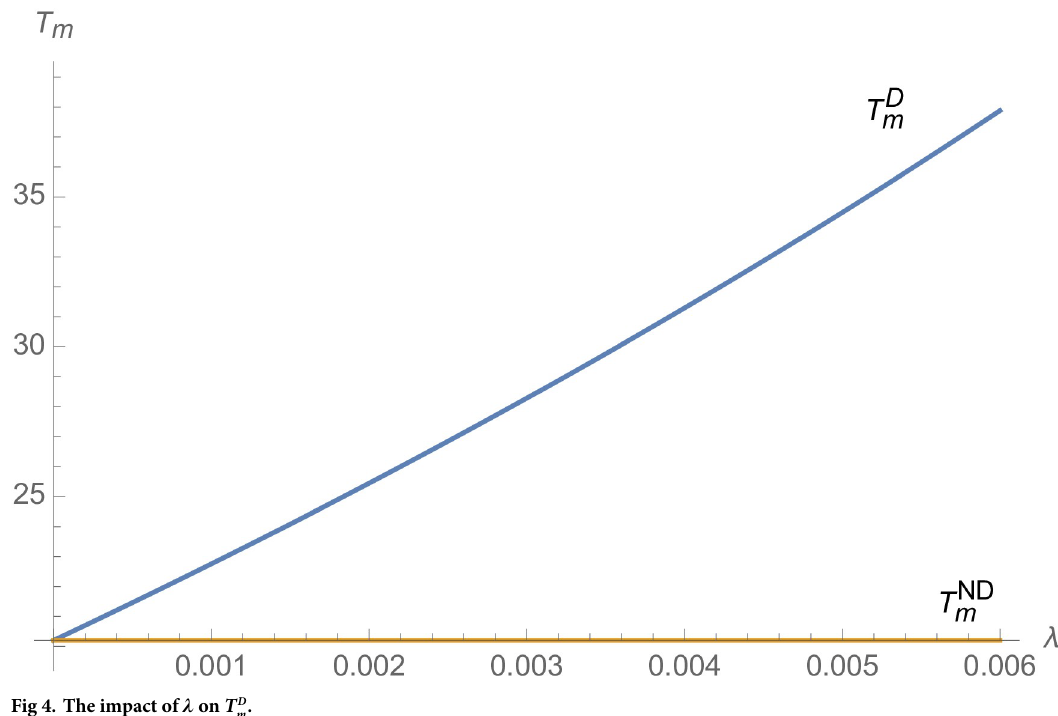
Fig 4. The impact of λ on T D